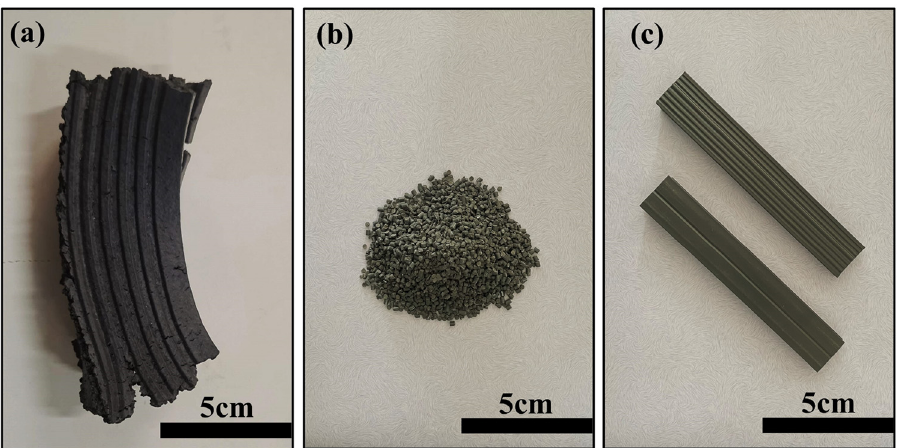
Figure 5: Macroscopic images of ( a ) unmodi fi ed r - PVC/CFA composites, ( b ) modi fi ed r - PVC/CFA - P, and ( c ) modi fi ed r - PVC/CFA